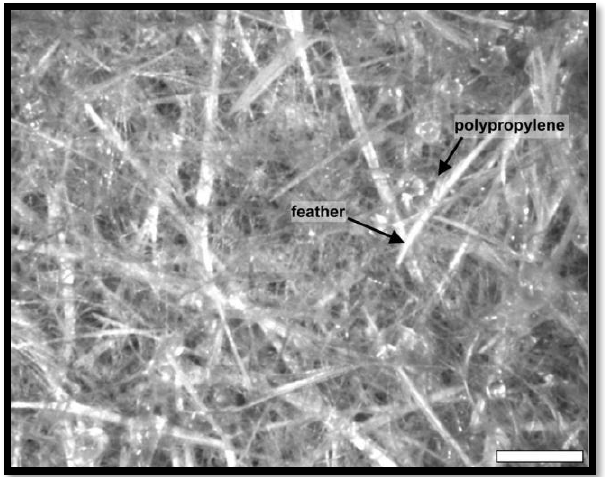
Figure 5. Images of wet lay prepreg after heating in a convection oven. Reprinted/adapted with permission from Ref. [49].